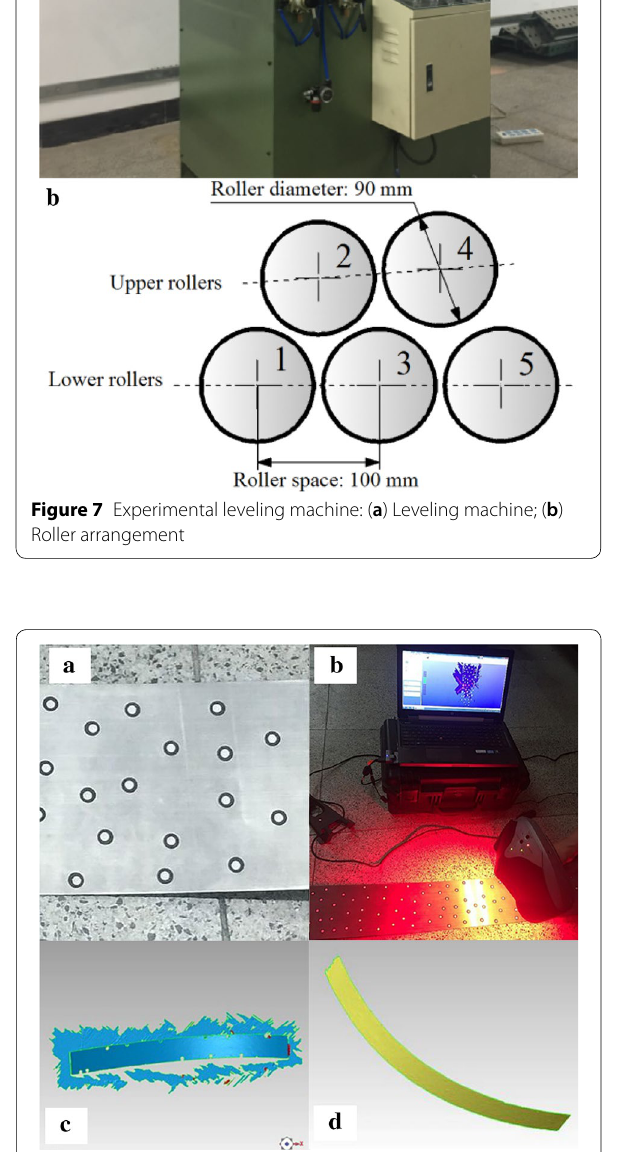
Figure 8 Measurement process: ( a ) Positioning marker arrangement; ( b ) Data acquisition site; ( c ) Model post-processing; ( d ) Surface topography